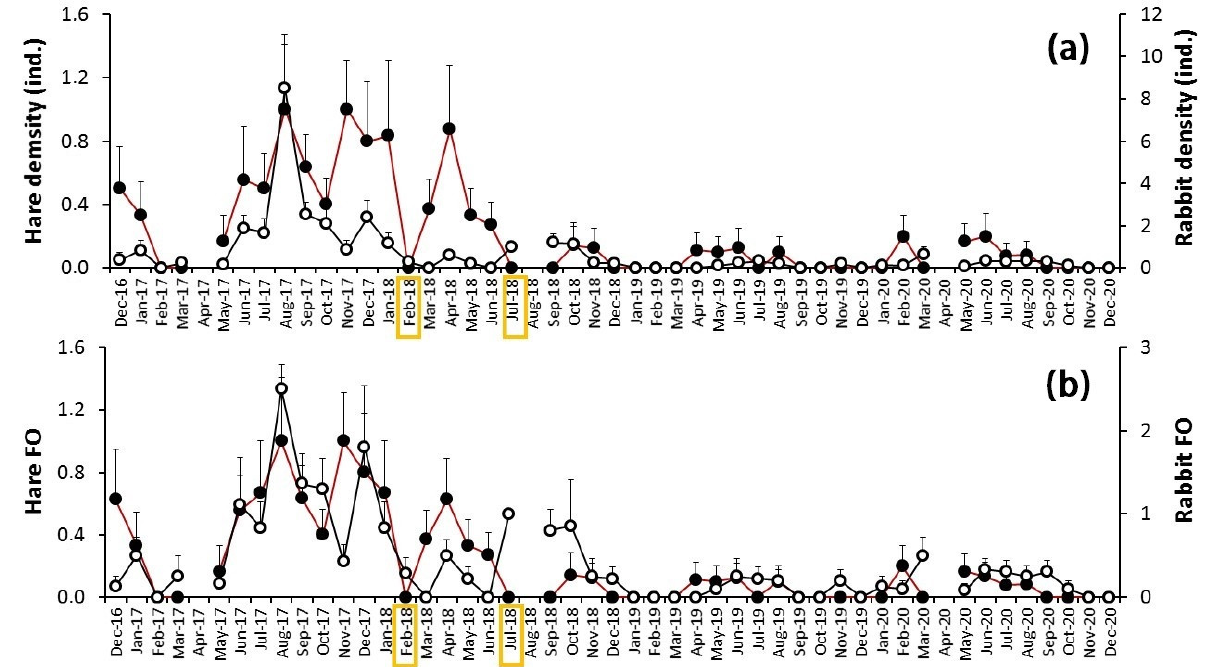
Figure 3. Evolution of ( a ) the monthly average relative density (individuals) (±SE) and ( b ) the average frequency of occurrence (±SE), based on the registers of the Iberian hare ( Lepus granatensis ) (black dots) and rabbit ( Oryctolagus cuniculus ) (white dots) in a Mediterranean agricultural area (S. Spain) between December 2016 and December 2020. Yellow squares mark the important events.